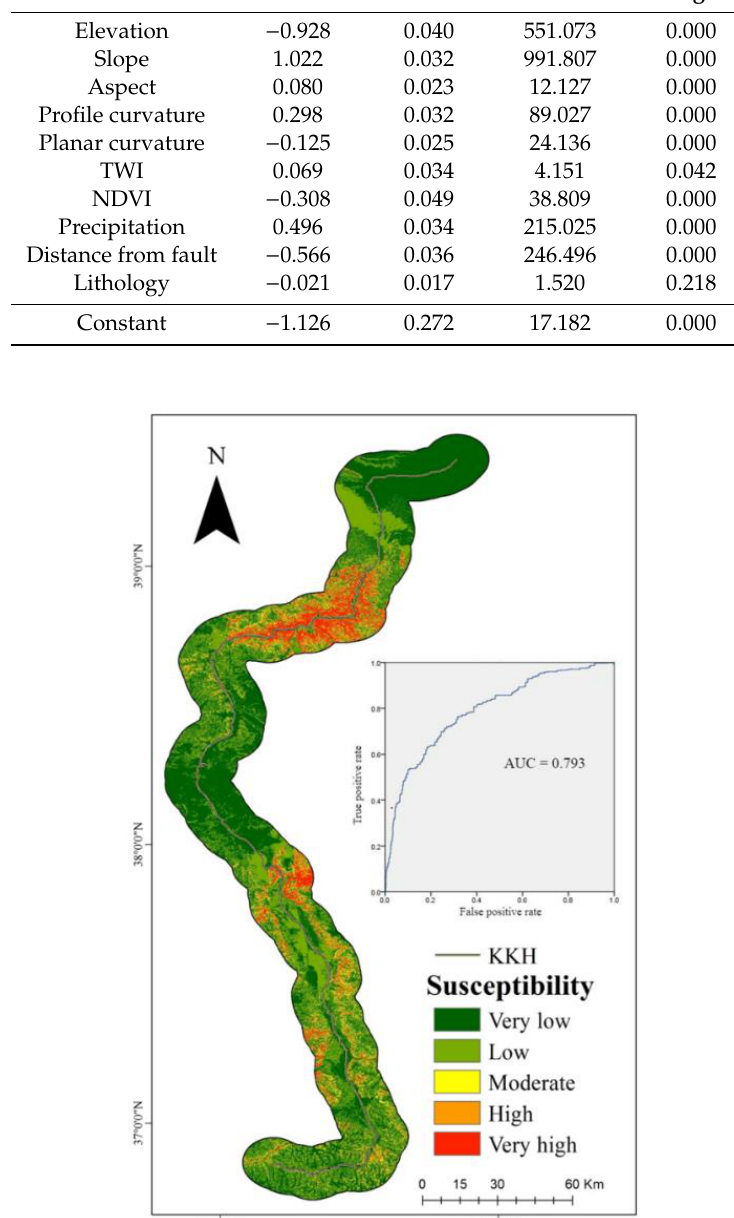
Figure 4. Landslide susceptibility map of the KKH and the related ROC curve, using logistic regression.